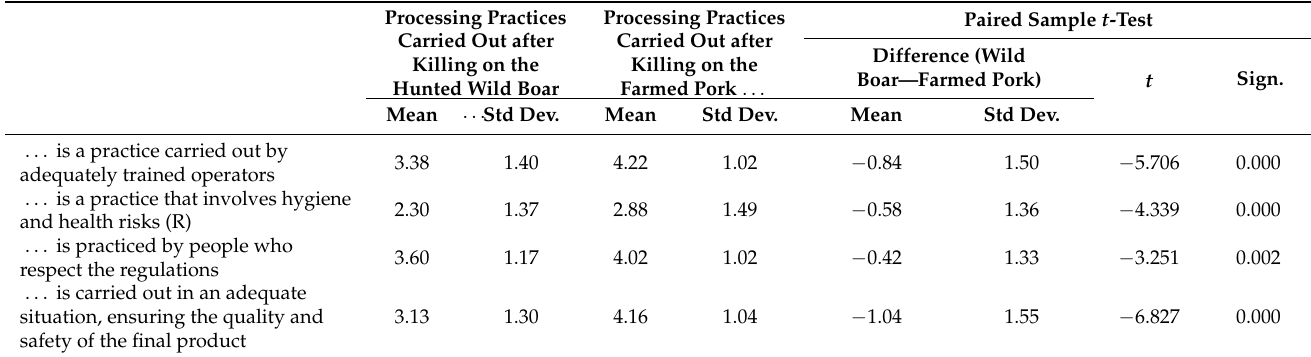
Table 6. Final product — Wild boar meat vs. Pork.